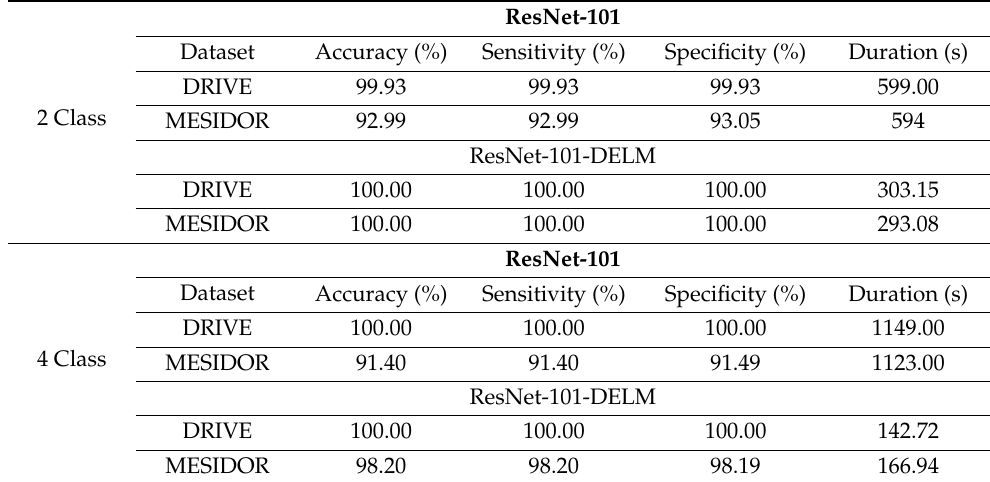
Table 7. Performance comparison of ResNet101 and ResNet101-DELM.